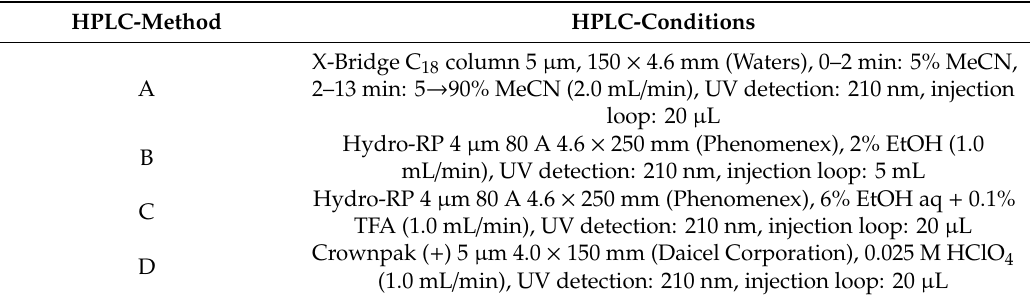
Table 3. Applied